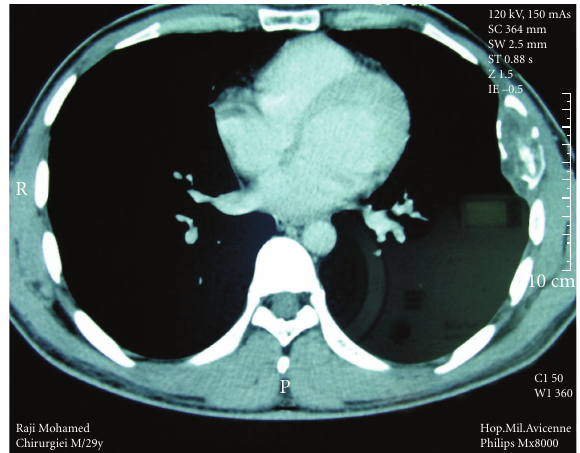
Figure 2: Chest CT scan: tumor of the 6th left rib without invasion of adjacent